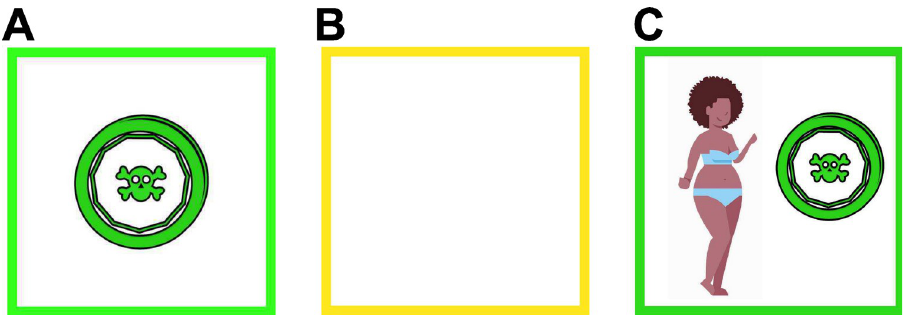
Fig 3. Possible reward outcomes during the task. In the neutral condition, participants could receive either (A) or (B), while in the BID condition they could receive either (C) or (B). An empty box (B) indicates no reward. The body type was selected by the participant before the task, more body type examples can be found in S1